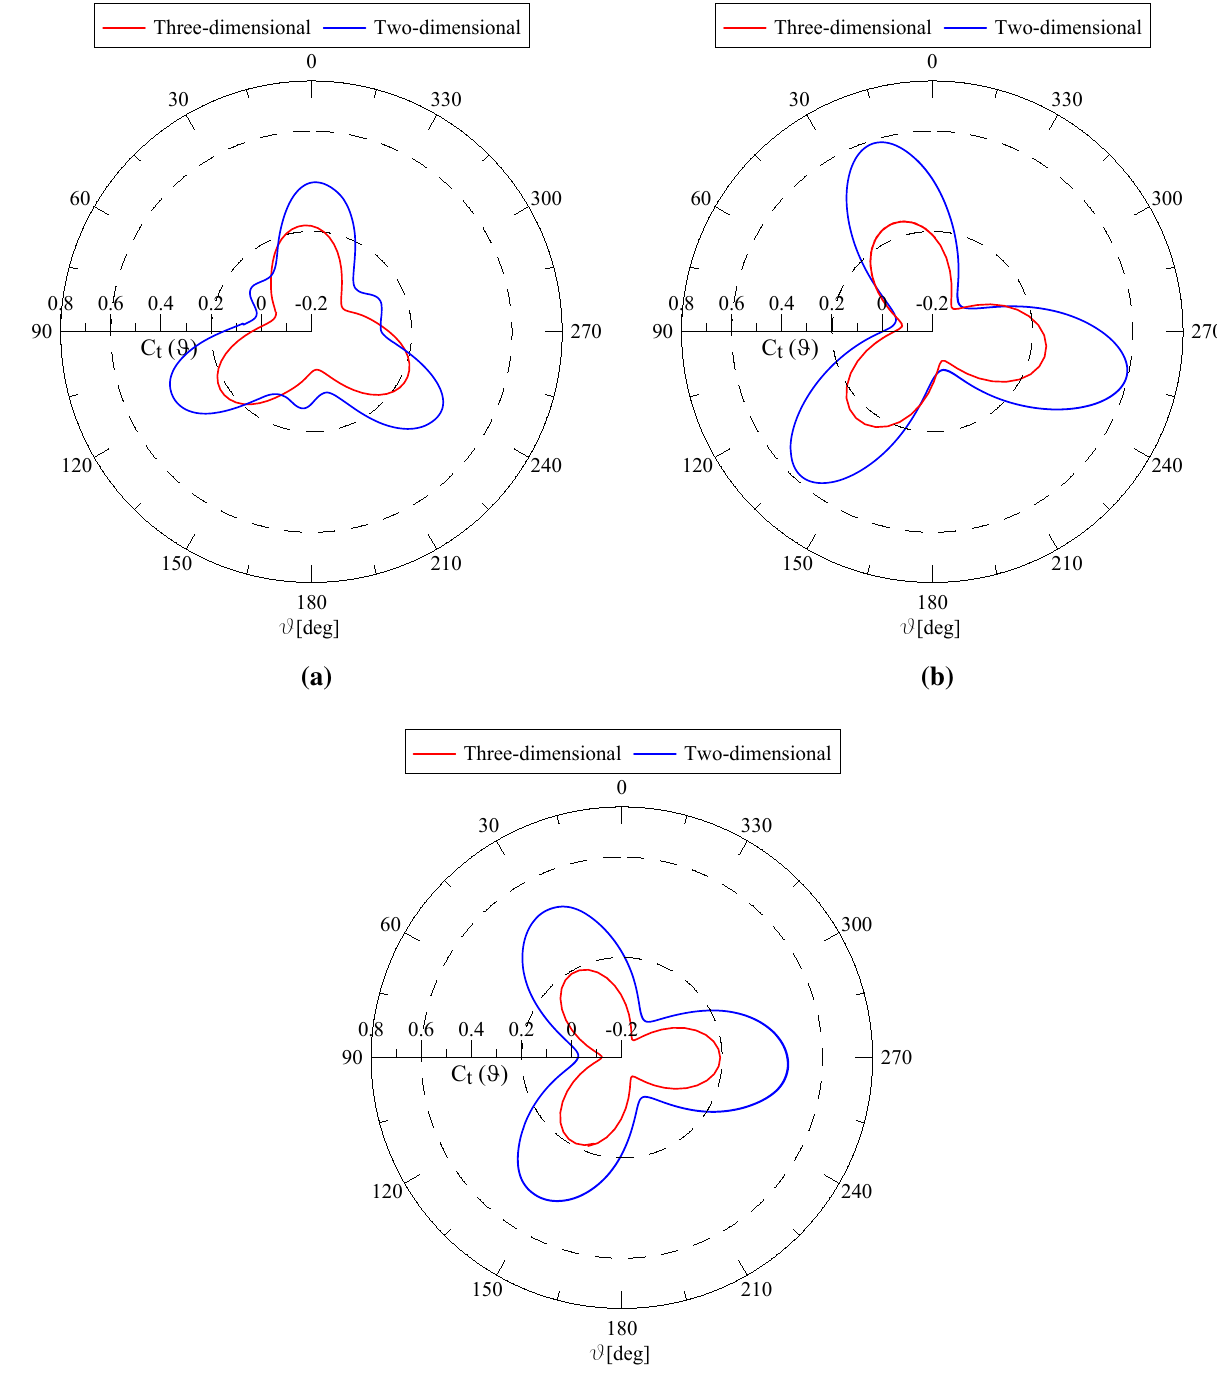
Figure 12. Two-dimensional and three-dimensional dynamic behavior for a Straight blade. ( a ) C 60 RPM; ( b ) C 90 RPM; ( c ) C 120 t t t